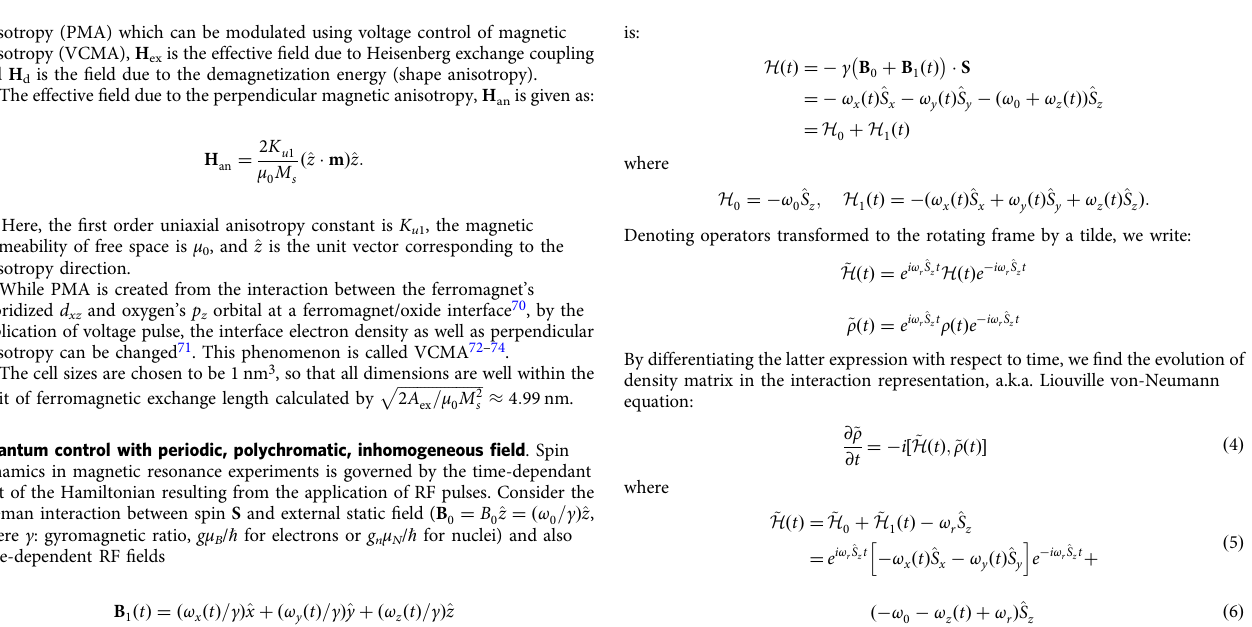
Fig. 8 Fourier components of induced magnetic fi eld. x , y , and z component of the induced magnetic fi eld with 500 MHz drive, are indicated in panels a – c respectively. Panels d – f are showing the results for 2 GHz drive. In each case Fourier components with N = 5, 10, 20 are used to reconstruct the original fi eld pro fi le. The fi rst 20 Fourier coef fi cients of each fi eld are plotted in the